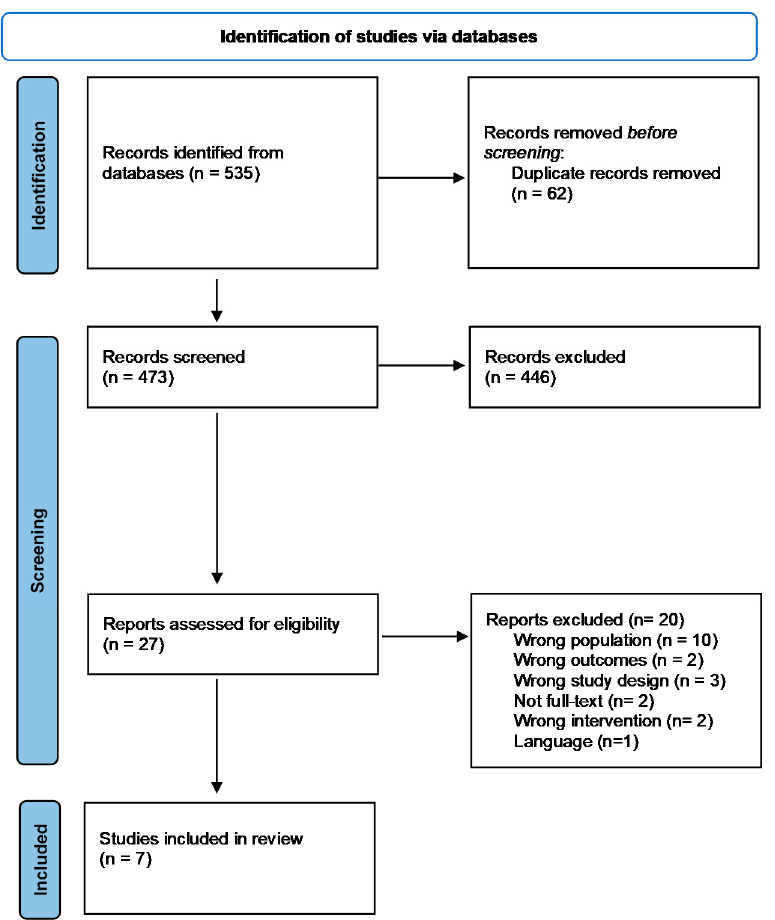
Figure 1. The detailed process of trial selection.